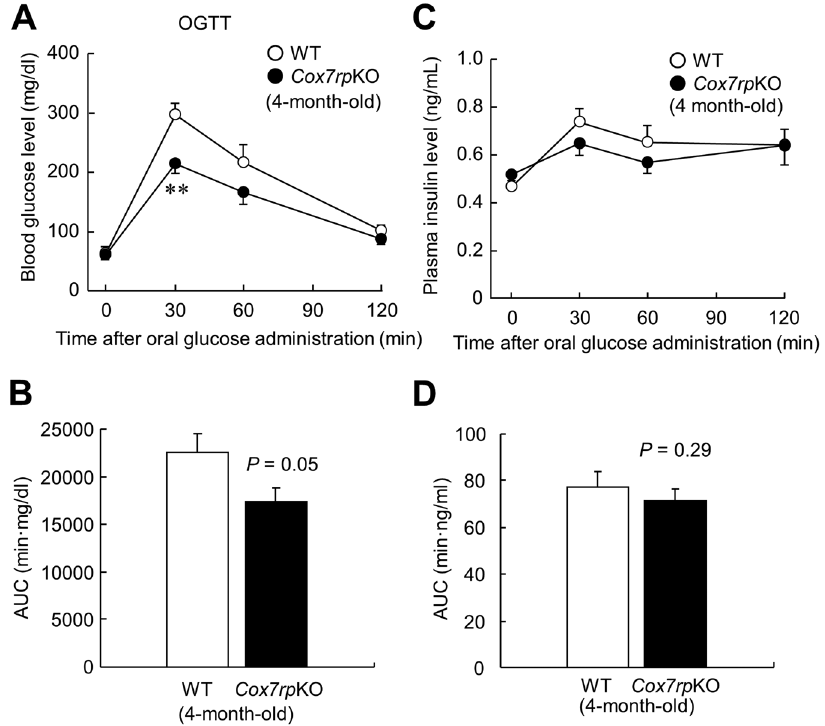
Figure 2. Lower blood glucose levels in 4-month-old Cox7rp KO mice versus WT mice during oral glucose tolerance test. ( A ) Blood glucose levels during oral glucose tolerance test (OGTT). Cox7rp KO and WT mice at 4-month-old were fasted for 16 h, then orally administered glucose (2 g/kg body weight). Blood samples were collected from the saphenous vein at indicated time points after glucose administration. Blood glucose levels were measured using a glucose analyzer. ( B ) Area under the curve (AUC) of blood glucose in OGTT. ( C ) Plasma insulin levels during OGTT. Plasma insulin levels were measured by using ELISA kits. ( D ) AUC of plasma insulin in OGTT. Data are presented as means ± SEM ( n = 6). * P < 0.05, ** P < 0.01, using Student’s t